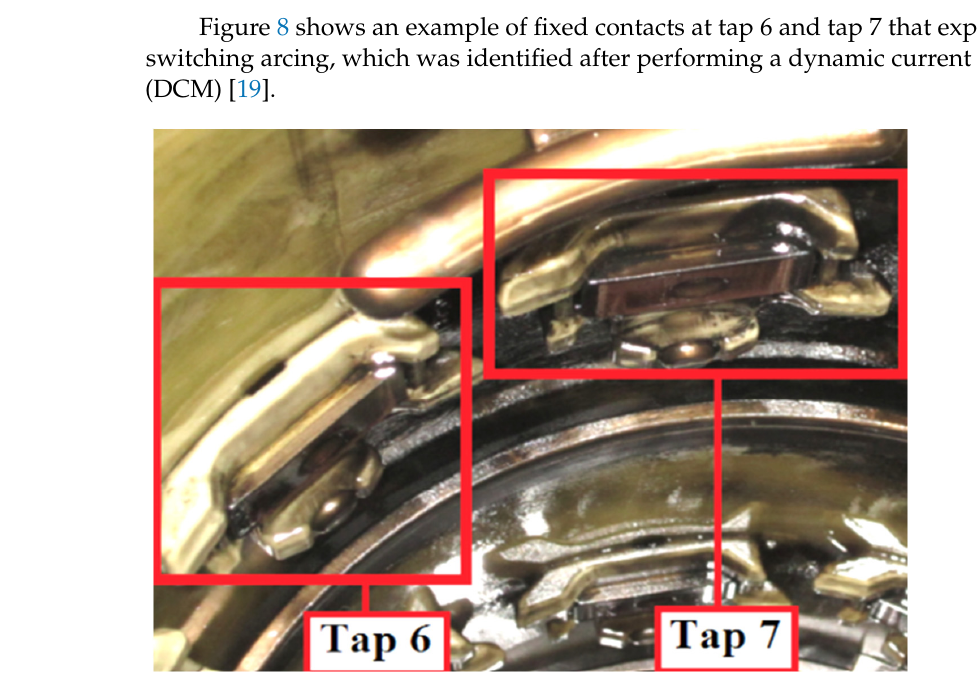
Figure 8. Fixed contacts at tap 6 and tap 7 experiencing high arcing at the red phase [19]. As the researchers continue their DCM assessment on the OLTC, arcing marks on three transition contacts of the red phase were identified as shown in Figure 9. The transition contacts were eroded and worn out due to switching arcs [19].